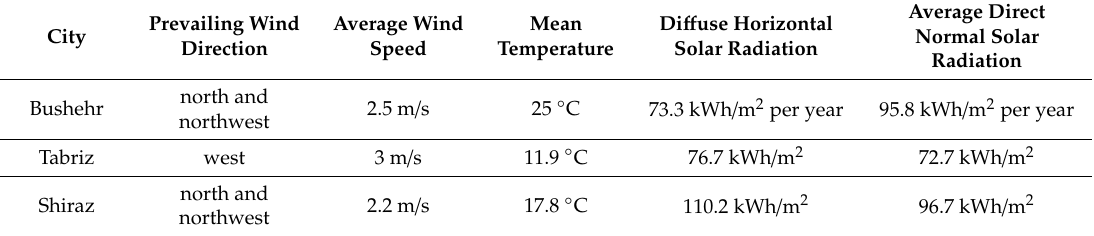
Table 1. Case studies: climatic data.